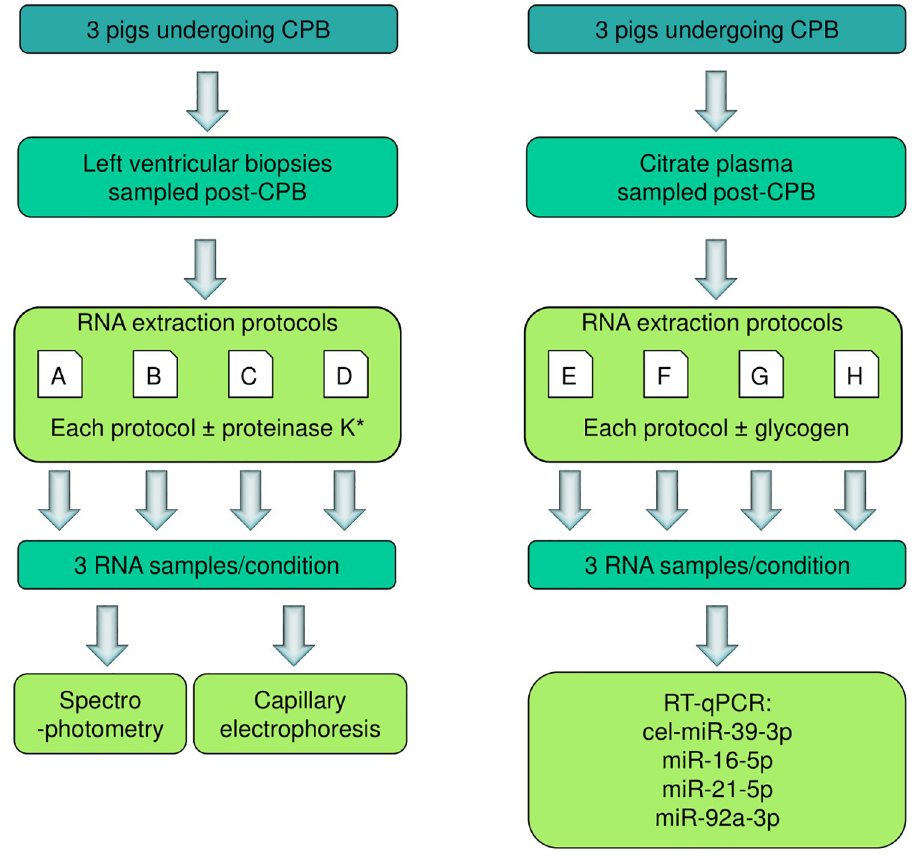
Fig 1. Summary of experimental design for Figs 2, 3 and 4. (A) Left ventricular biopsies were taken from three pigs undergoing cardio-pulmonary bypass (CPB). 7 biopsies were taken per pig. RNA was isolated from the biopsies using four commercially available kits; RNAqueous micro, mir Vana, miRCURY tissue, miRNeasy micro. Three kits (RNAqueous micro, mir Vana, miRNeasy micro) were tested with and without an additional proteinase K digestion step, giving 7 protocols in total. The miRCURY tissue protocol includes a proteinase K digestion, therefore this kit was not tested without this. RNA samples were characterised by spectrophotometry and capillary electrophoresis. (B) Blood samples were taken from three pigs undergoing CPB and processed to plasma. RNA was isolated from the plasma using four commercially-available kits; miRNeasy serum/plasma, mir Vana, miRCURY biofluids, Norgen Biotek plasma/serum. Each kit was tested with and without glycogen as a co-precipitant, giving 8 protocols in total. RNA samples were evaluated by RT-qPCR for the exogenous spike-in cel-miR-39-3p, and endogenous miRNAs miR- 16-5p, miR-21-5p,